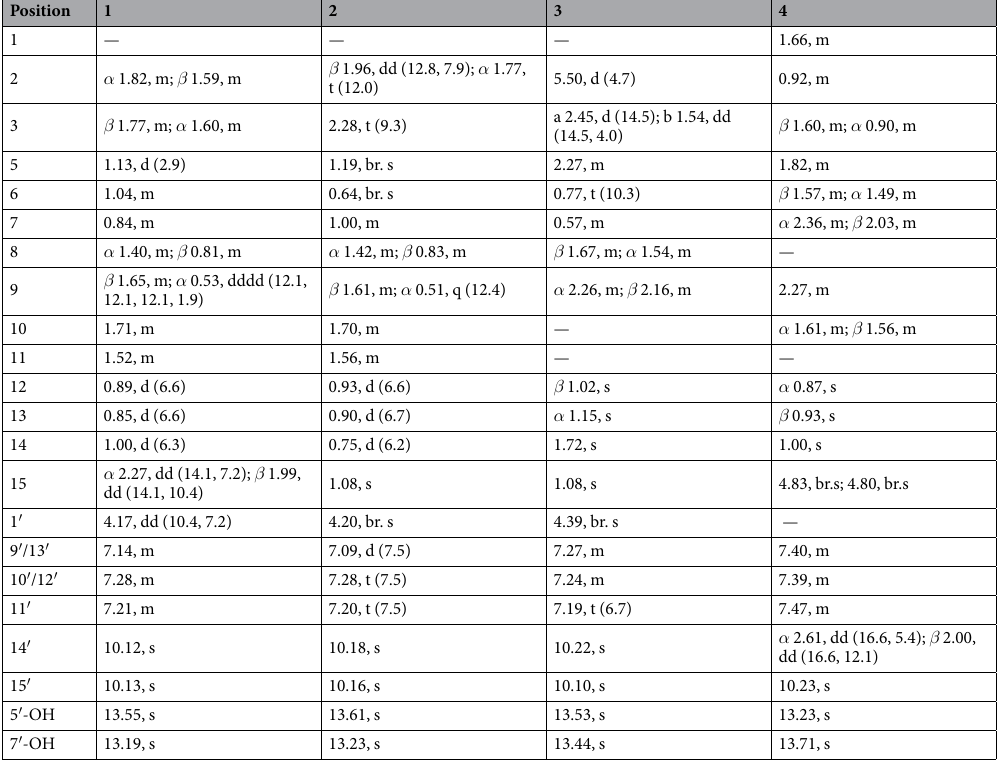
Table 1. 1 H NMR (400 Hz) data of compounds 1 – 4 in CDCl 3 ( δ in ppm, J in Hz).